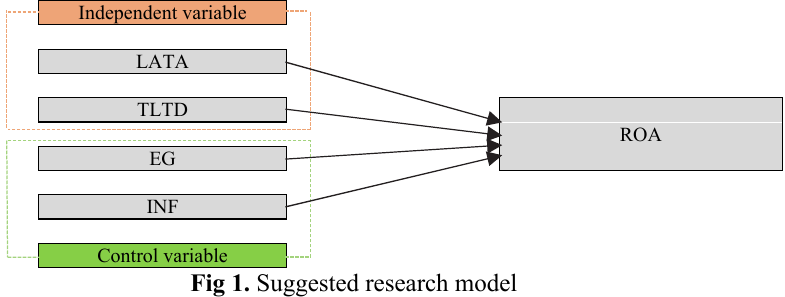
Fig 1. Suggested research model